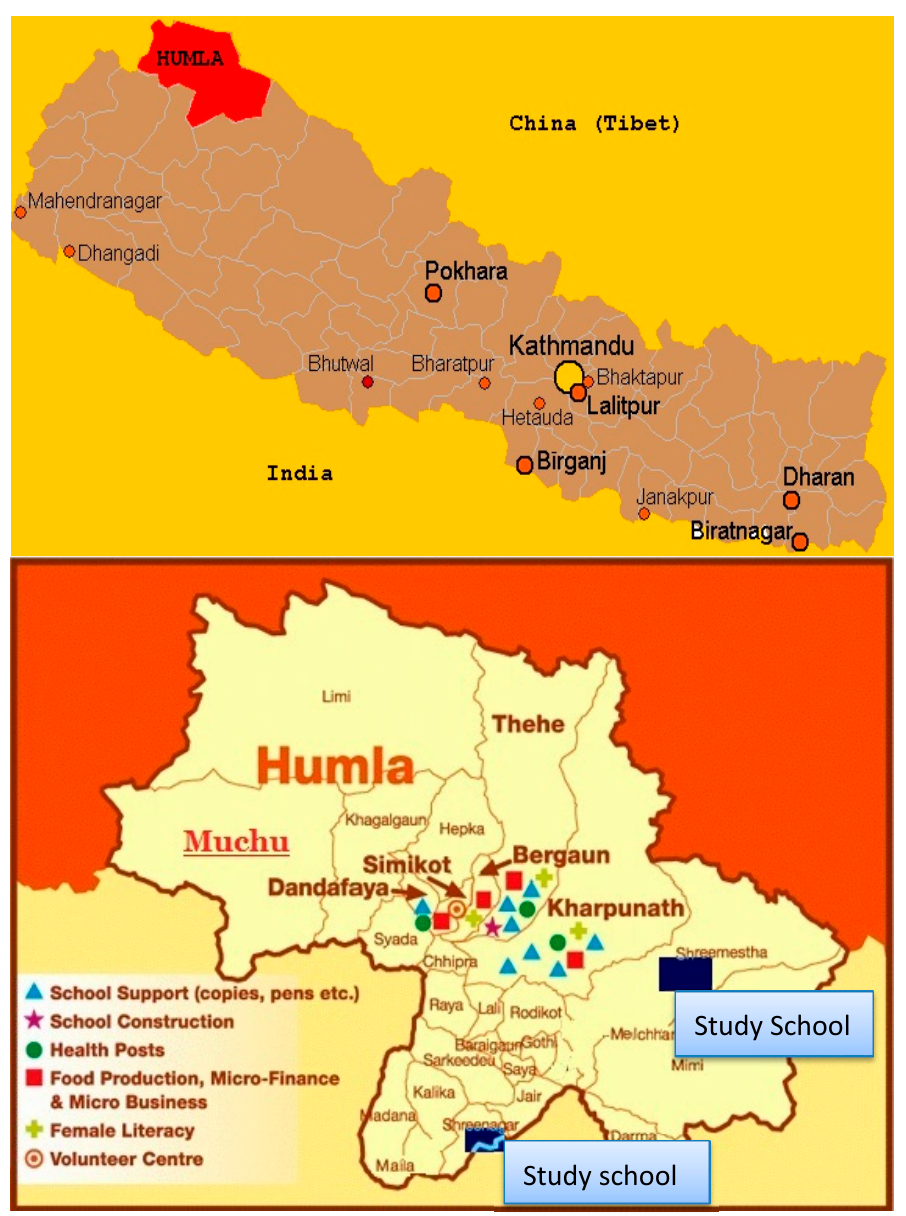
Figure 1. Area of study.